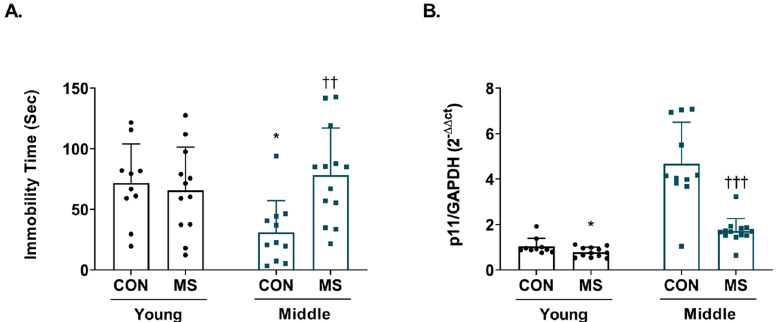
Figure 2. Changes in immobility on the FST and hippocampal p11 levels in young adult and middle-aged mice following maternal separation (MS) exposure. ( A ) Immobility time in the FST was measured at 2 months (young adulthood) or 8 months (middle adulthood). ( B ) p11 mRNA levels in the hippocampus were measured using quantitative real-time polymerase chain reaction (qRT-PCR). All analyses were performed on the hippocampus. All quantities were normalized to glyceraldehyde-3-phosphate dehydrogenase (GAPDH). Data are expressed as values relative to mean ΔCt (control group on young adulthood) using the 2 −ΔΔCt method and are presented as mean ± standard error of the mean (SEM; n = 10–12/group, young adulthood; n = 11–13/ group, middle adulthood) * p < 0.05 vs. control in young adulthood; †† p < 0.01 vs. control in middle adulthood; ††† p < 0.001 vs. control in middle